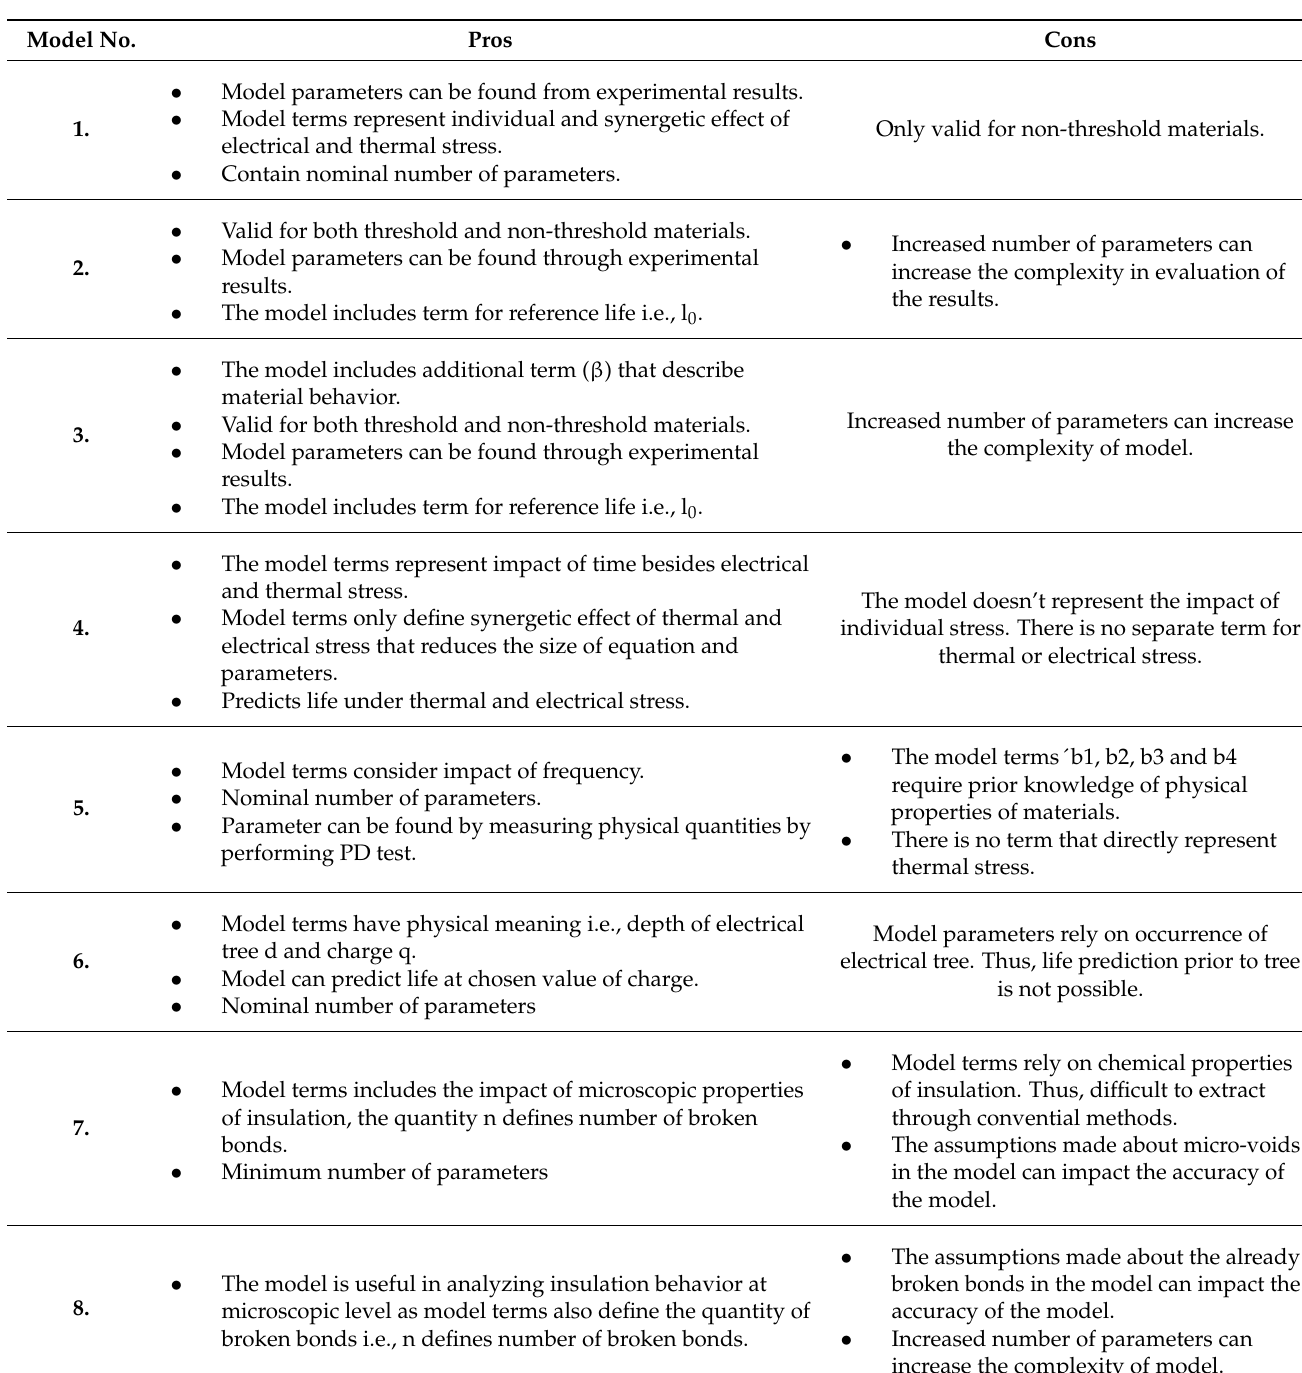
Table 2. Pros and cons of reviewed multistress aging